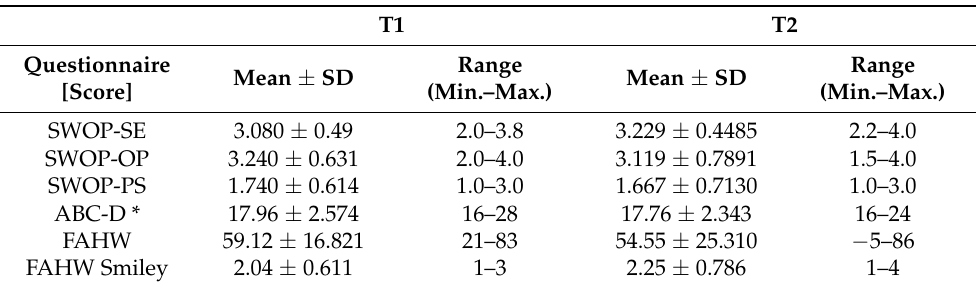
Table 4. Descriptive statistics of the questionnaire scores at the first and second study visit (T1, n = 25, and T2, n = 21). SE = self-efficacy (possible range: 5 to 20), OP = optimism (possible range: 2 to 8), PS = pessimism (possible range: 2 to 8). Activities-Specific Balance Confidence scale (ABC-D, possible range: 16 to 64), general habitual well-being (FAHW, average reference values between 35 and 50, smiley score ranging from 1 to